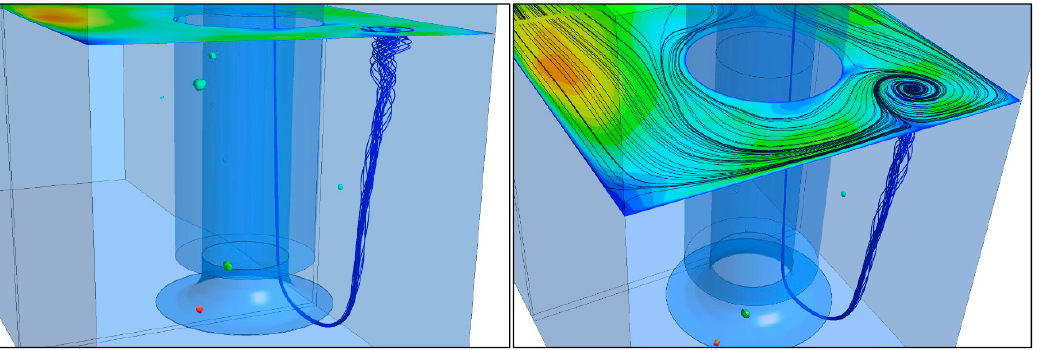
Figure 17. CFD results showing streamline indicating the presence of a surface vortex.